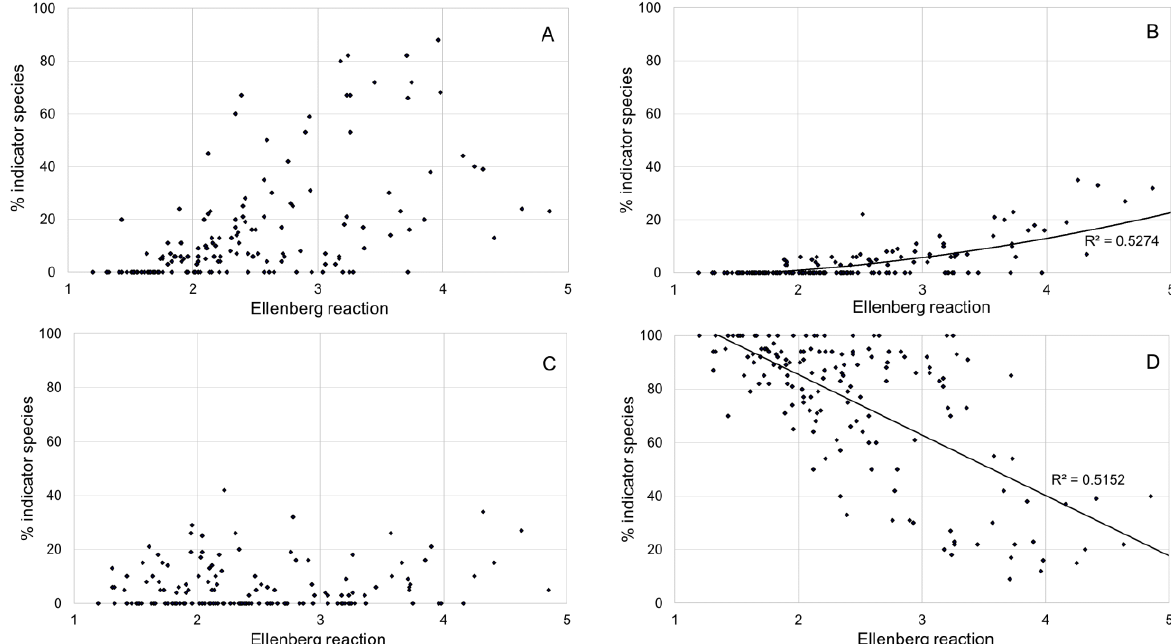
Figure 5. Percentages of plant species indicating mire margin to expanse gradient (y-axis) in relation to Ellenberg reaction value (x-axis). Subtypes of mire margin influence are (A) Sumpfigkeit , (B) Quelligkeit and (C) Bruchmoorigkeit . (D) refers to mire expanse vegetation including indifferent species. Percentages of plant species indicators for mire margin–expanse gradient are derived from the presence-absence data for vascular plants and mosses. Ellenberg nitrogen values are derived from cover values for vascular plants. Regression lines are shown only for correlations with statistical significance ( R 2 >